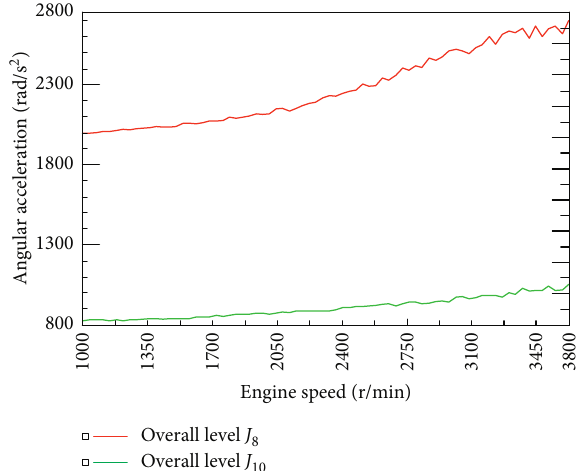
Figure 37: The overall angular acceleration curves of the primary flywheel and the input shaft of the gearbox matching the DMF under driving conditions.